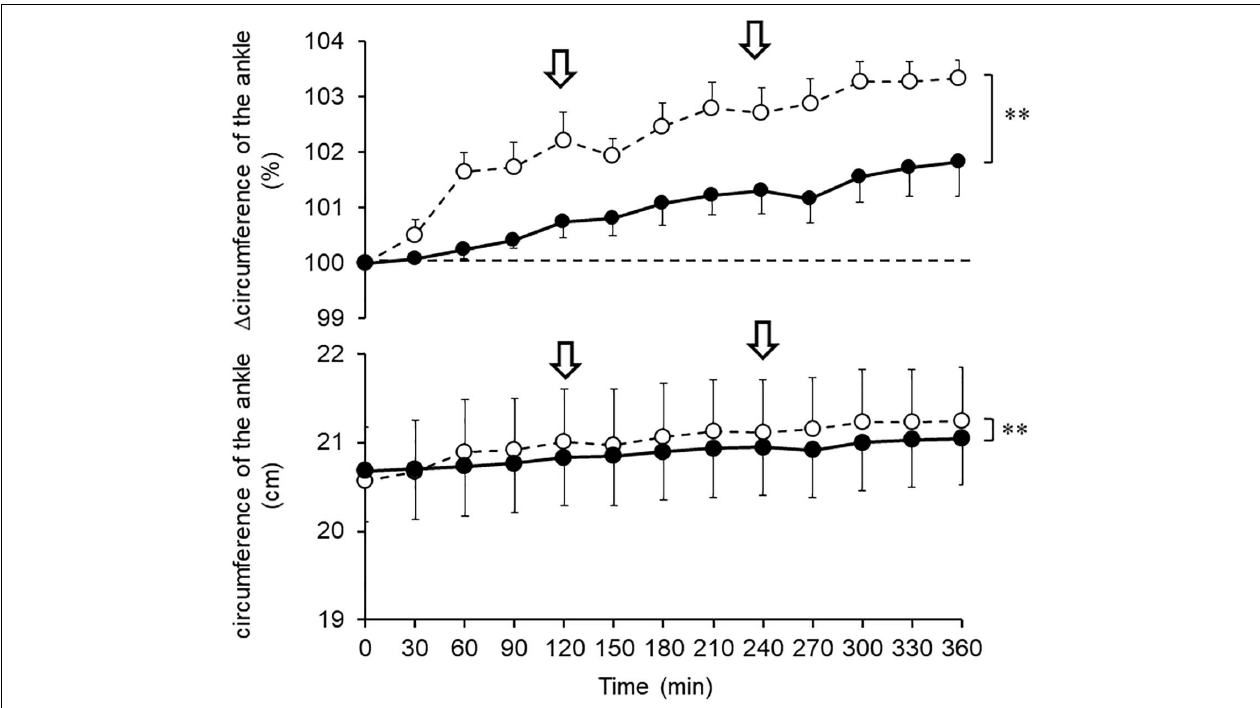
FIGURE 3 | Changes in circumference of the ankle after 1,000 mg of G-Hsp ( • ) and Placebo ( ◦ ) beverage ingestion. The arrow indicates the walking for urination, mean and SE, n = 6, Asterisks indicate significant differences ( ∗∗ P < 0.01).